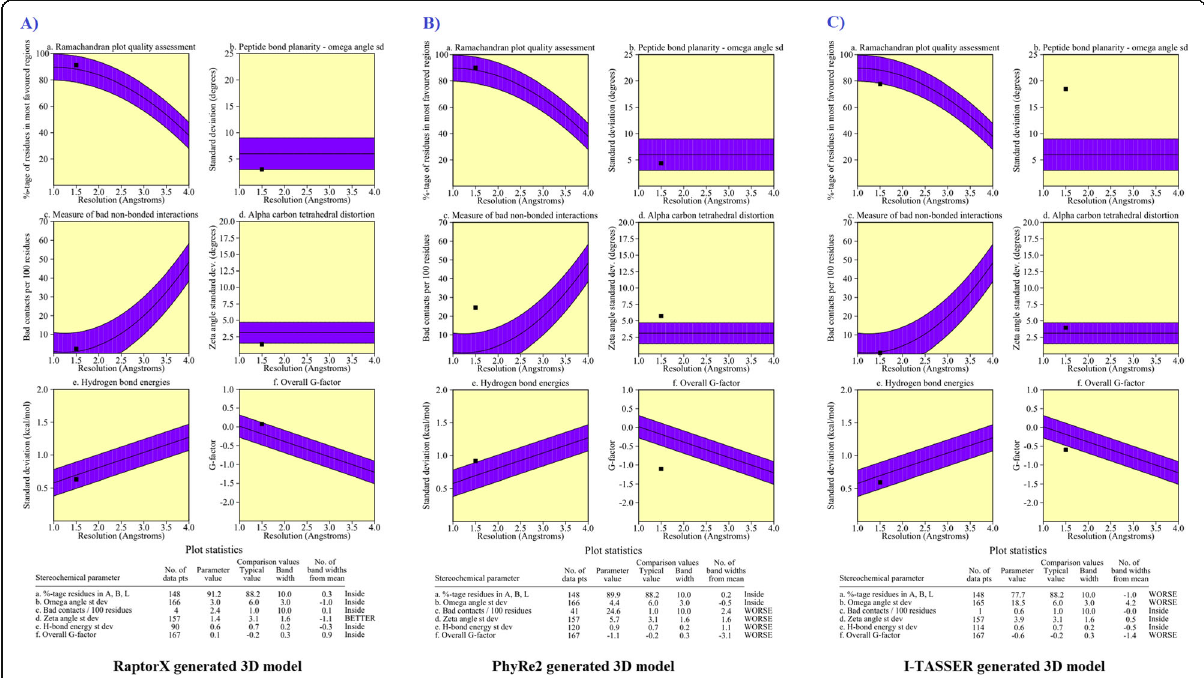
Fig. 3 Stereochemical comparison among three common 3D structure modeling servers in terms of generating the best tertiary structure of leptin. a ) RaptorX generated leptin. b ) PhyRe2 generated leptin. c ) I-TASSER generated leptin. All parameters revealed from RaptorX built structures showed accepted limit values and more qualified parameters compared with PhyRe2 and I-TASSER built structures, respectively. The